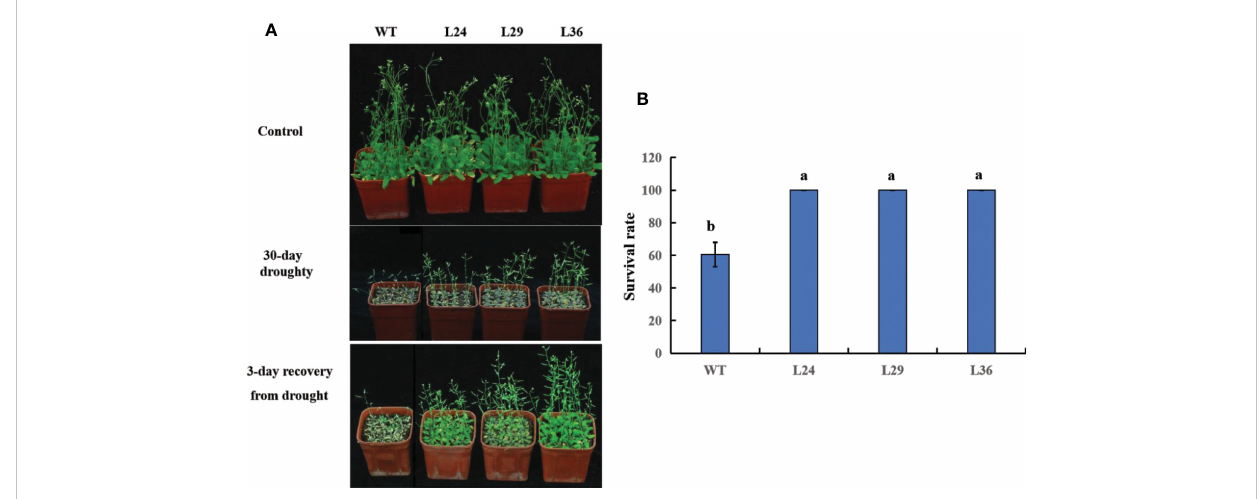
FIGURE 8 The effect of GhGT23 overexpression on Arabidopsis in response to 30-day drought treatment. (A) Images of WT and transgenic Arabidopsis plants overexpressing GhGT23 (L24, L29, and L36) 30 days after a normal watering schedule (control) and drought. Plants were also imaged 3 days after being watered at the end of the drought period. (B) Survival rates of WT and transgenic plants after a 3-day recovery period from drought treatment. Each bar represents the average of three experiments with 64 plants used in each experiment. Error bars indicate standard deviation and different letters indicate signi fi cant differences (p < 0.05), which were determined using ANOVA, followed by Duncan ’ s multiple comparison